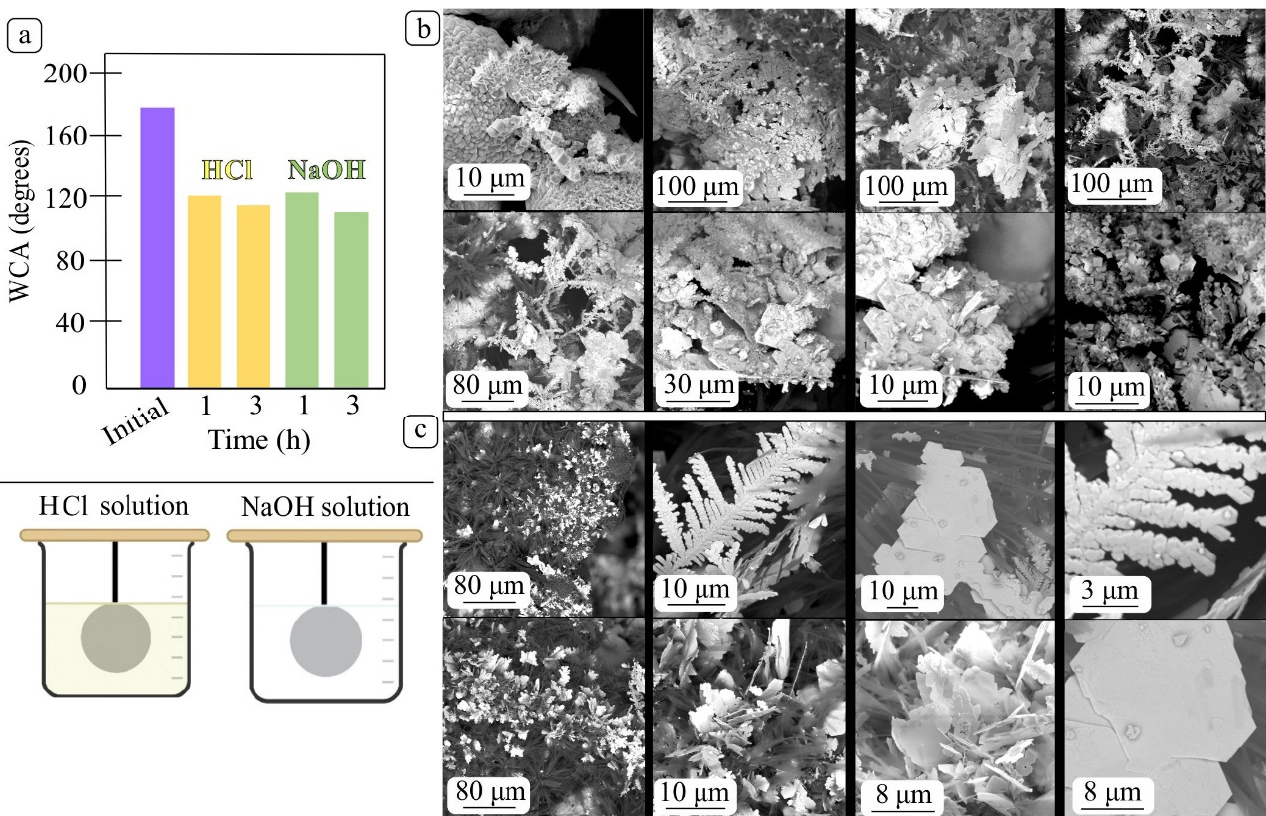
Figure 9. ( a ) WCA measurements after chemical treatment in acidic and alkaline solutions. SEM images of morphologies after ( b ) after 1 h in HCl solution, ( c ) after 1 h in NaOH solution.